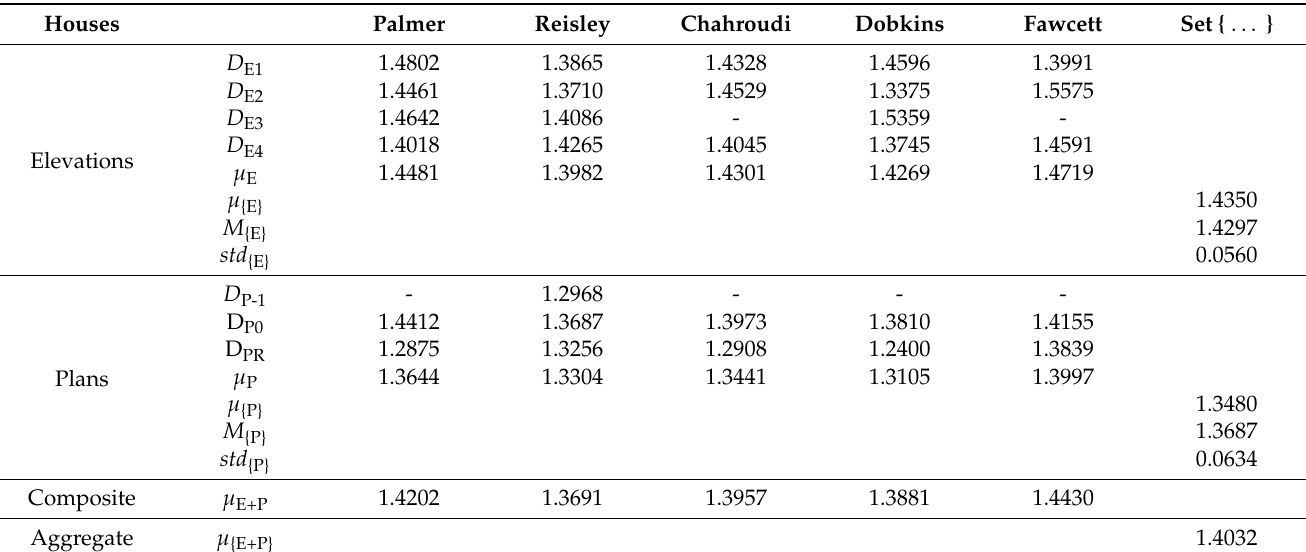
Table A3. Usonian set,